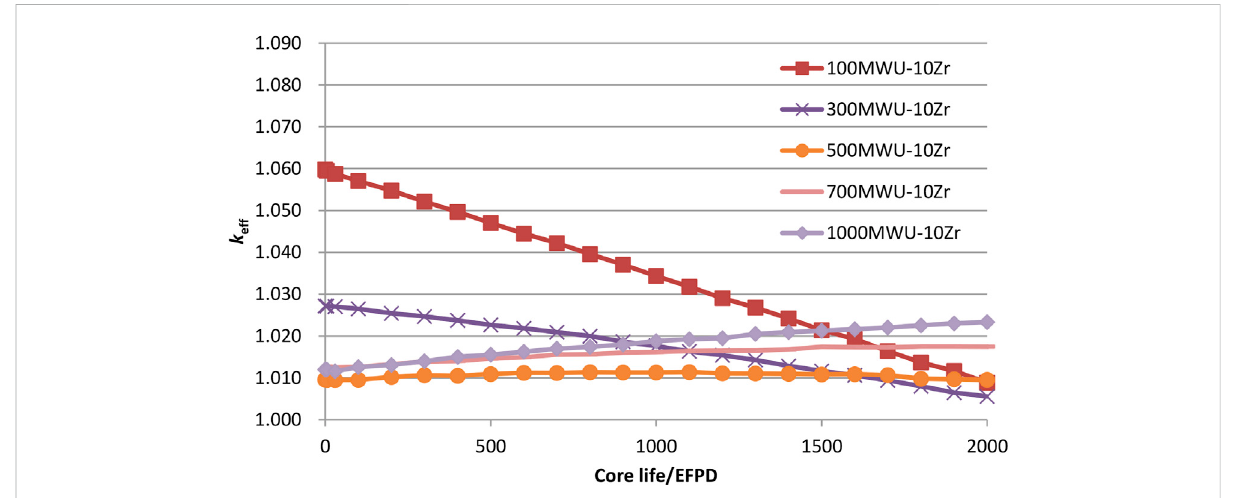
FIGURE 9 Core k eff curves of all the schemes with U-10Zr fuel along with core life.